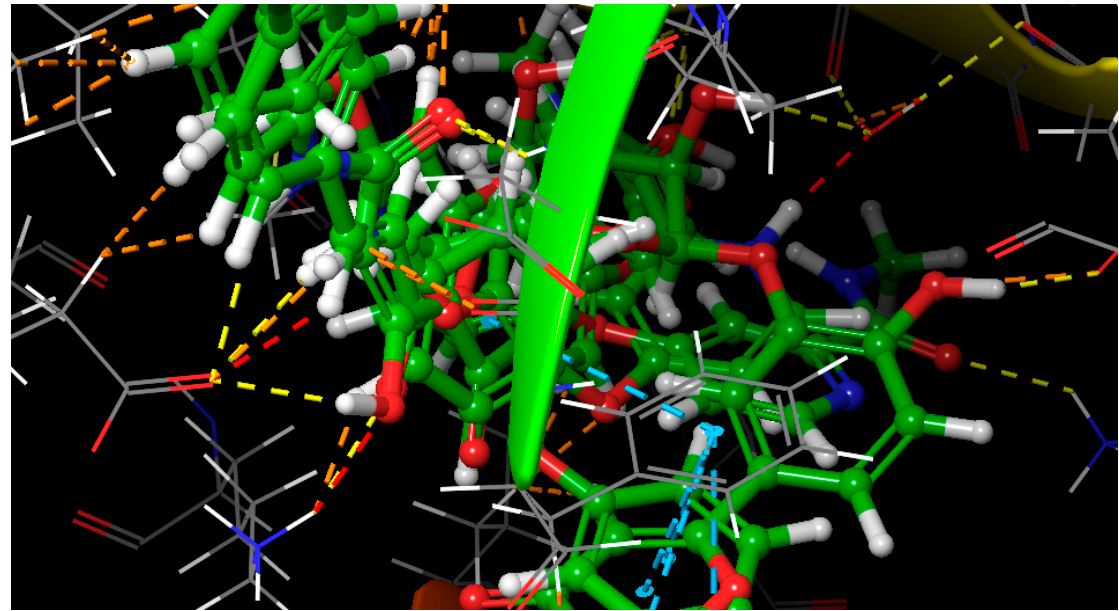
Figure 7. 3D binding mode and overlay of isolates, rutin and Sorafenib in mitogen-activated protein kinase (MAPK) active domain (PDB 5EKN). Image shows hydrogen bonding as a yellow dotted line, pi-pi staking interactions as a cyan dotted line, and hydrophobic interactions as an orange dotted line.